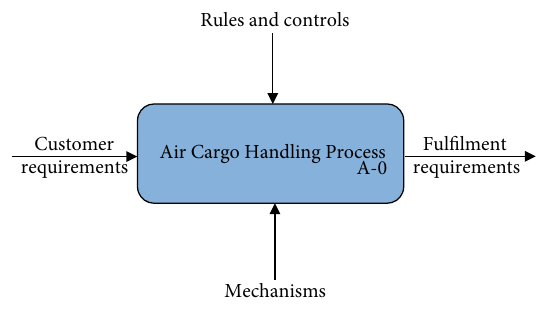
Figure 1: Context diagram of Air Cargo Handling